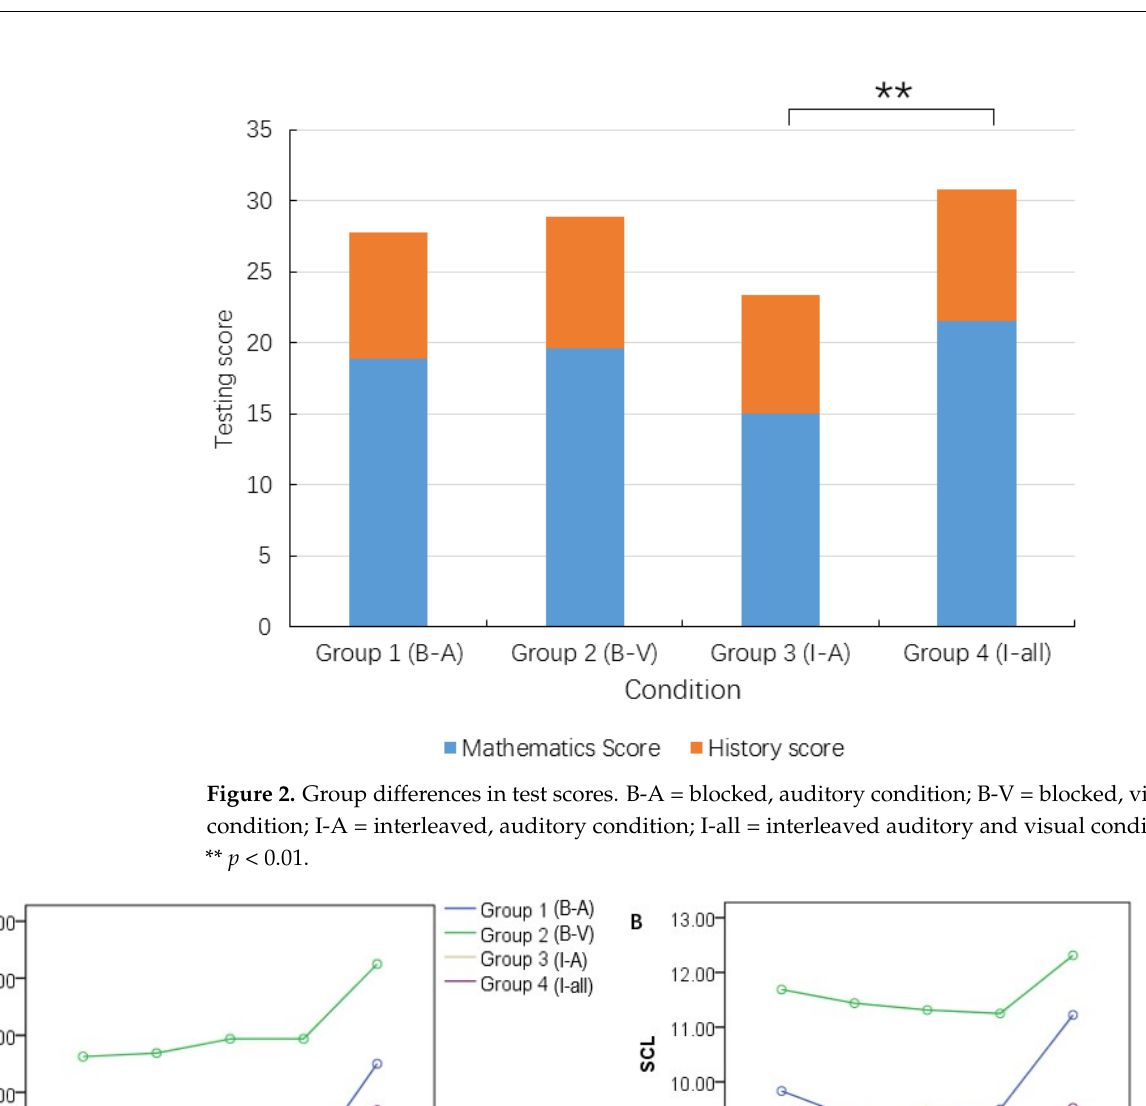
Figure 2. Group differences in test scores. B-A = blocked, auditory condition; B-V = blocked, visual condition; I-A = interleaved, auditory condition; I-all = interleaved auditory and visual condition. ** p < 0.01.